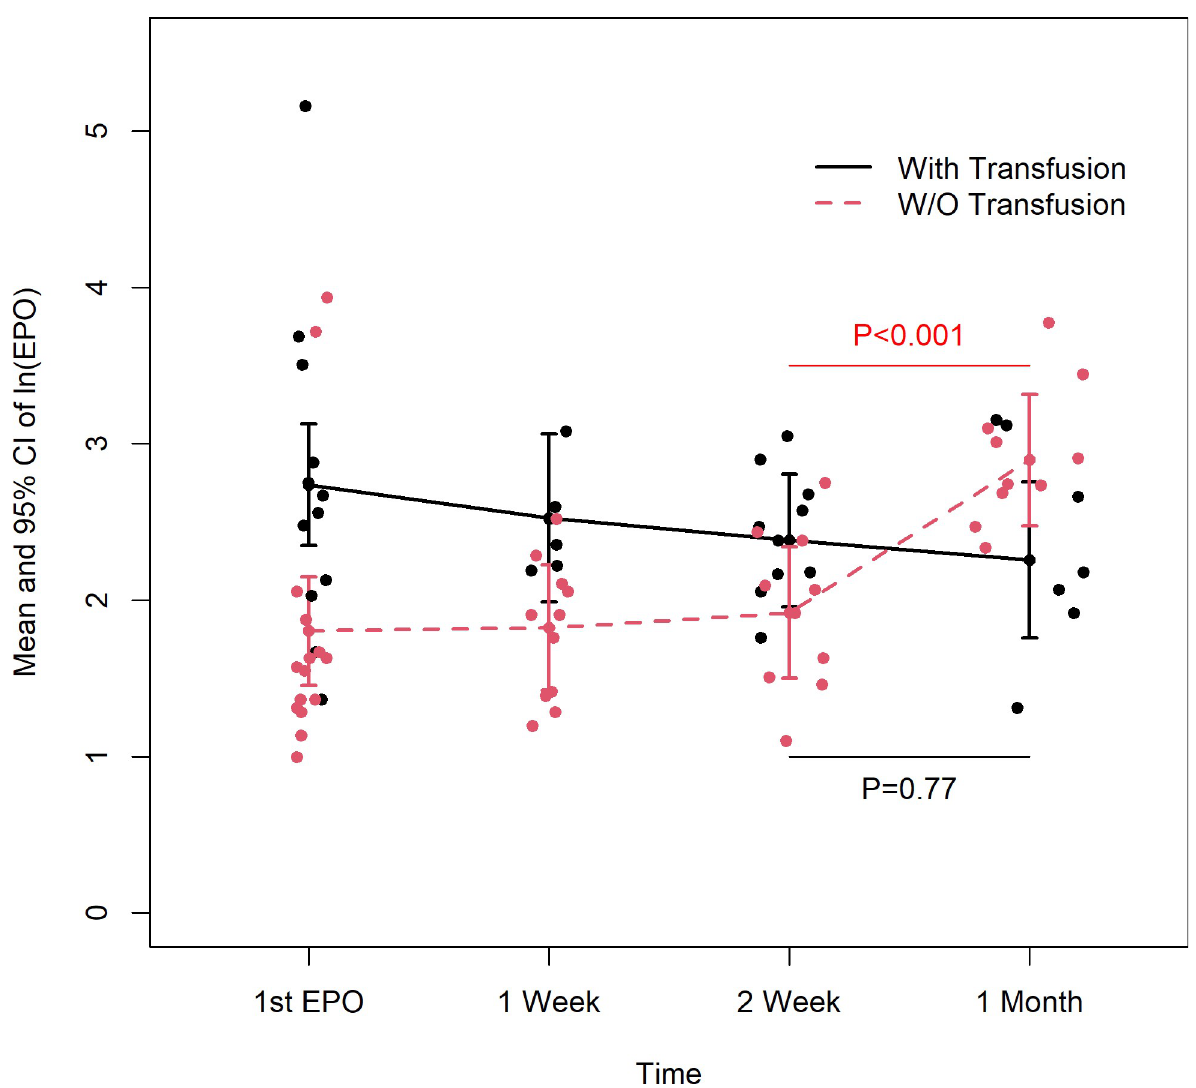
Fig 2. Ln[EPO] over time by RBC transfusion status. Ln[EPO] over Time by RBC Transfusion Status. Scatterplot of ln(EPO) at each time point for subjects with (black) and without (red) RBC transfusion, with mean and 95% confidence interval. First EPO was higher for subjects that required transfusion (p = 0.016); by 1 month, EPO was higher for non-transfused subjects (p = 0.048). [EPO] increased between week 2 and 4 only in the non-transfused group (p < 0.001 vs. p =